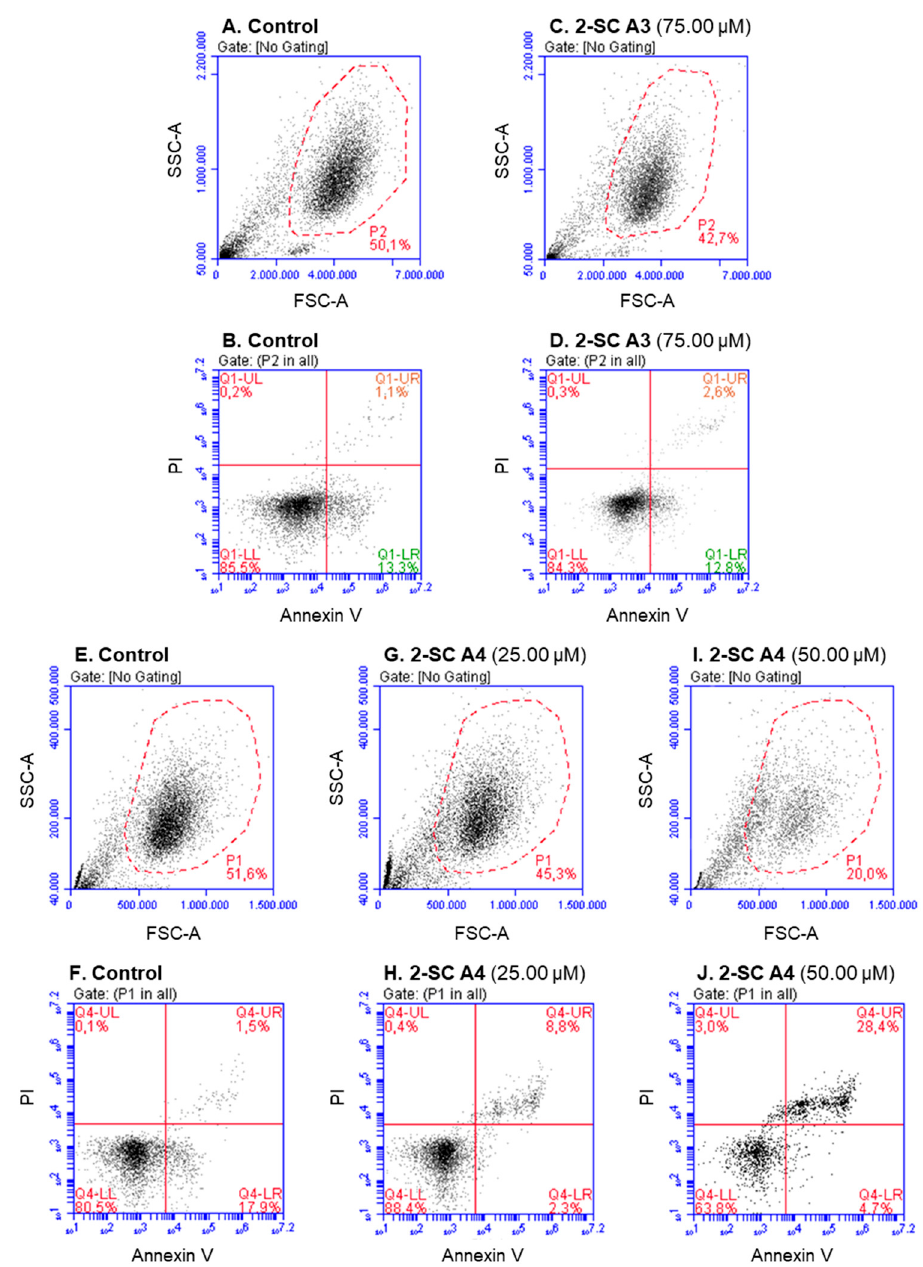
Figure 4. Effect of 2-SC A3 and A4 on human neutrophils’ viability. Representative flow cytometry plots of forward scatter area (FSC-A, xx axis) / side scatter area (SSC-A, yy axis) histogram ( A , C , E , G , I ), and annexin V (xx axis) / propidium iodide (PI, yy axis) histogram ( B , D , F , H , J ). ( A , B , E , F ): control (without 2-SC); ( C , D ): 2-SC A3 (75.00 µ M); and ( G – J ): 2-SC A4 (25.00 and 50.00 µ